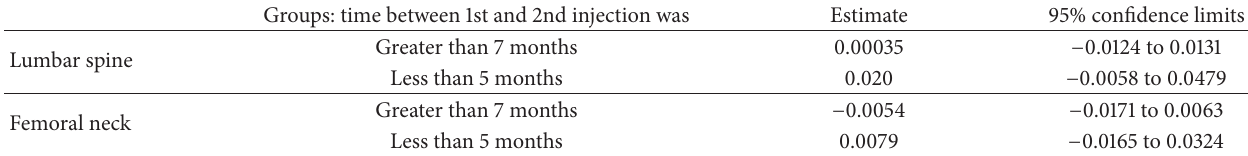
Table 3: Regression analysis comparing change in bone mineral density (BMD) between groups [reference group: 5–7 months] ∗ . Groups: time between 1st and 2nd injection